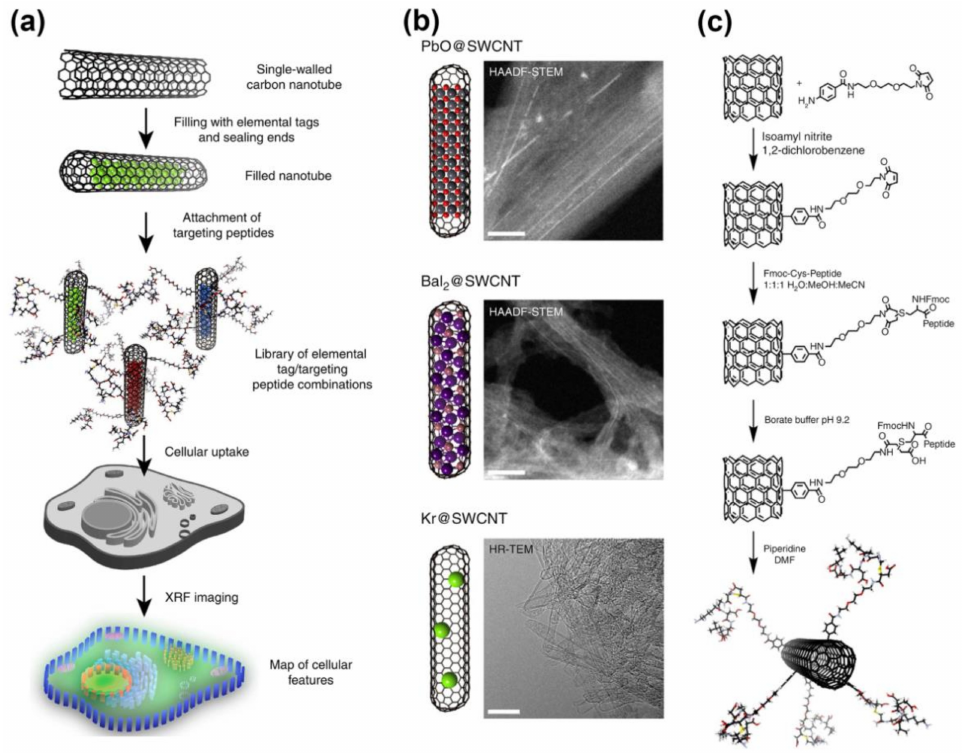
Figure 3. ( a ) Design of XRF-contrast carrier systems purposed to probe cellular organelles through XRF mapping. ( b ) Structural models and both HAADF-STEM and HR-TEM images of SWCNTs filled with PbO, BaI 2 , and Kr. ( c ) Scheme of functionalization of filled SWCNTs with peptides. Reproduced from [152]. Published by SpringerNature under a Creative Commons Attribution 4.0 International